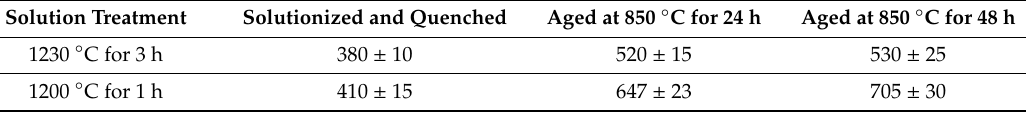
Table 5. Microhardness values (VHN) of the studied alloys for di ff erent states. Solution